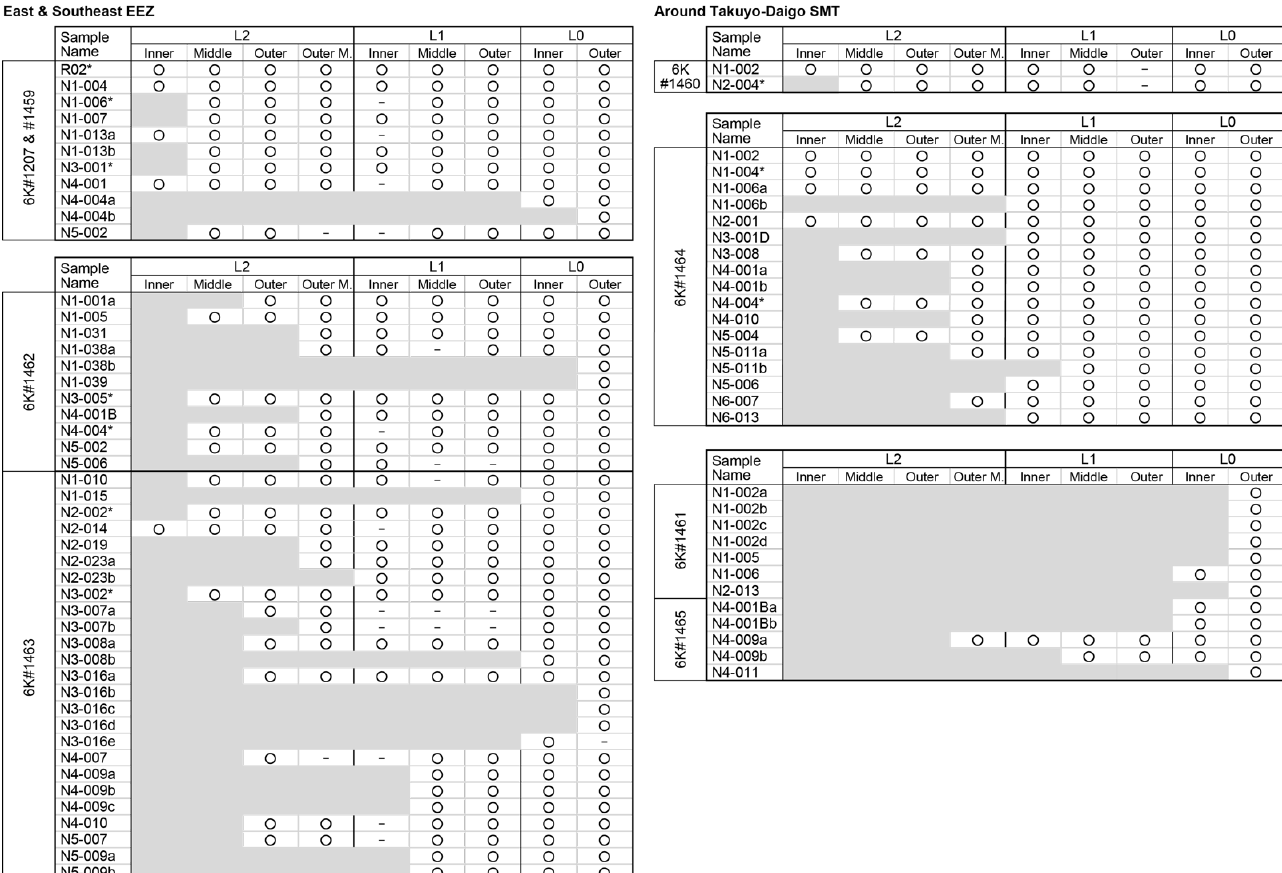
Figure 5. Observed layers for each sample collected from the nodule field around Minamitorishima Island. In this figure, the sites are arranged from north (upper) to south (lower) in each region. The identified sublayers in all samples, including samples previously reported by [13] and the samples shown as ‘*’ with the sample name, are indicated by circles (O) in each box. Layer identification is based on both µ-XRF mapping (the merged multichemical feature map) of the samples and the definition of each sublayer proposed by [13] (Figure 3). The box marked by ‘ - ‘ indicates the complete absence of the sublayer. The gray bar corresponds to the nuclei shown in Figures 4 and S1 – S5 to easily recognize the innermost layer of each sample. The alphabet ‘a’, ‘b’, ‘c’, ‘d’, and ‘e’ with the sample name indicate the samples consisting of multiple nuclei or aggregates of several nodules.